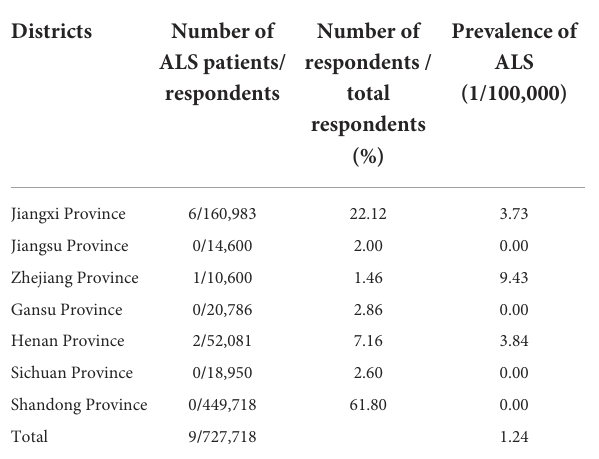
TABLE 3 General clinical and demographic information of ALS patients identified in population survey.